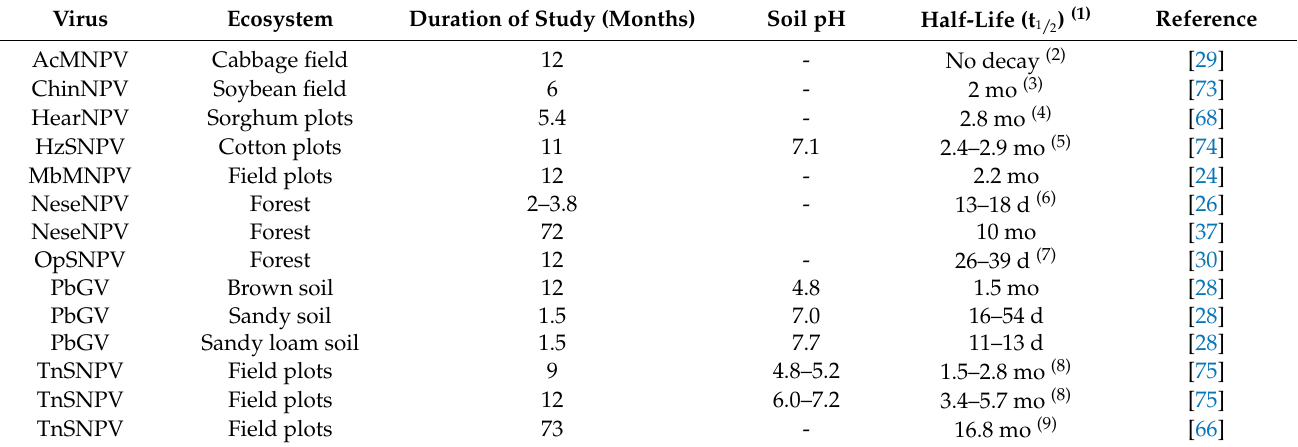
Table 3. Persistence of virus occlusion bodies (OBs) in agricultural and forest